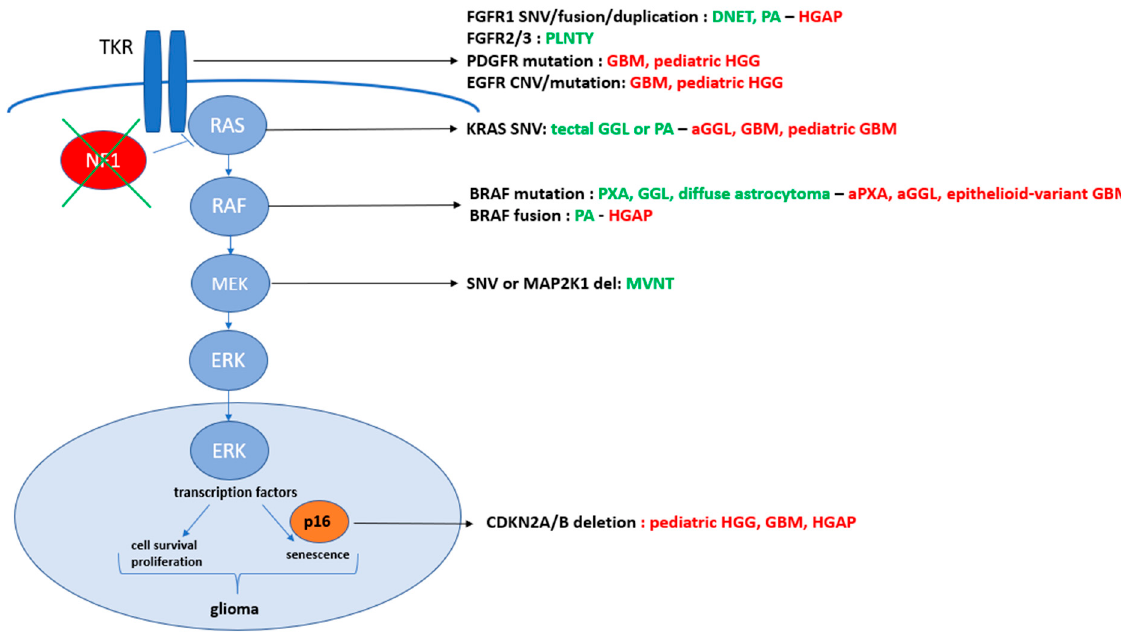
Figure 1. Summary of the molecular abnormalities in the MAPK pathway driving low- and high-grade gliomas. The low-grade entities are listed in green with their more frequent paired molecular aberrations, whereas the high-grade gliomas (HGGs) are described in red and LGG in greed. The alterations are listed in black color. DNET, dysembryoplastic neuroepithelial; PA, pilocytic astrocytoma; HGAP, high-grade astrocytoma with piloïd features; PLNTY, polymorphous low-grade neuroepithelial tumor of the young; GBM, glioblastoma; HGG, high-grade glioma; GGL, ganglioglioma; aGGL, anaplastic GGL; PXA, pleomorphic xanthoastrocytomas; aPXA, anaplastic PXA; MVNT, multinodular and vacuolating neuronal tumors.